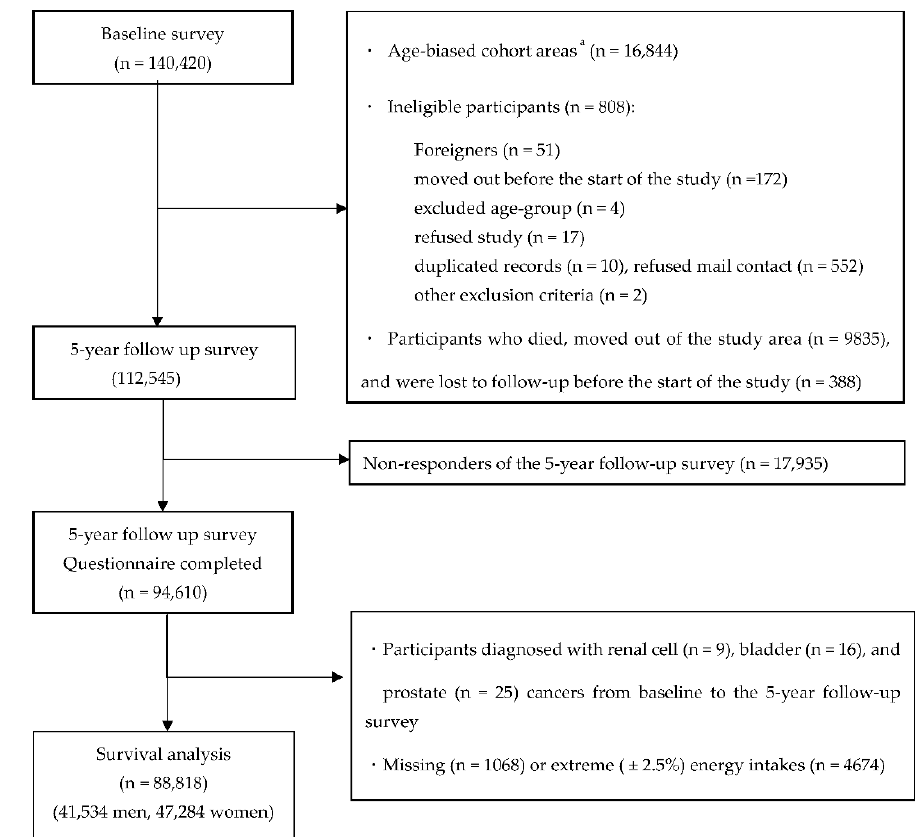
Figure 1. Flow diagram of eligibility for analysis. a Only participants aged 40 and 50 years received baseline questionnaires in these areas.